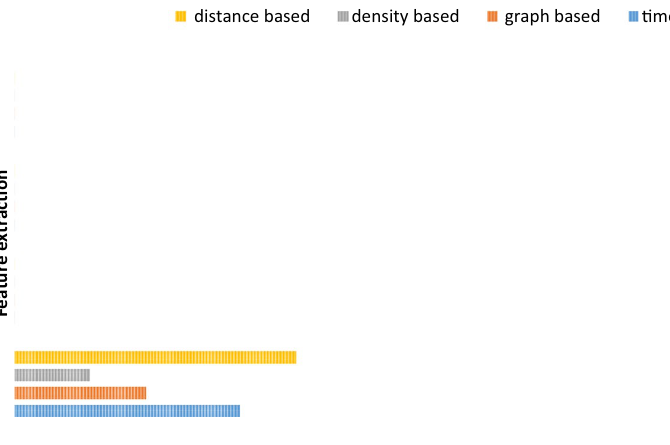
Fig. 7 Feature extraction